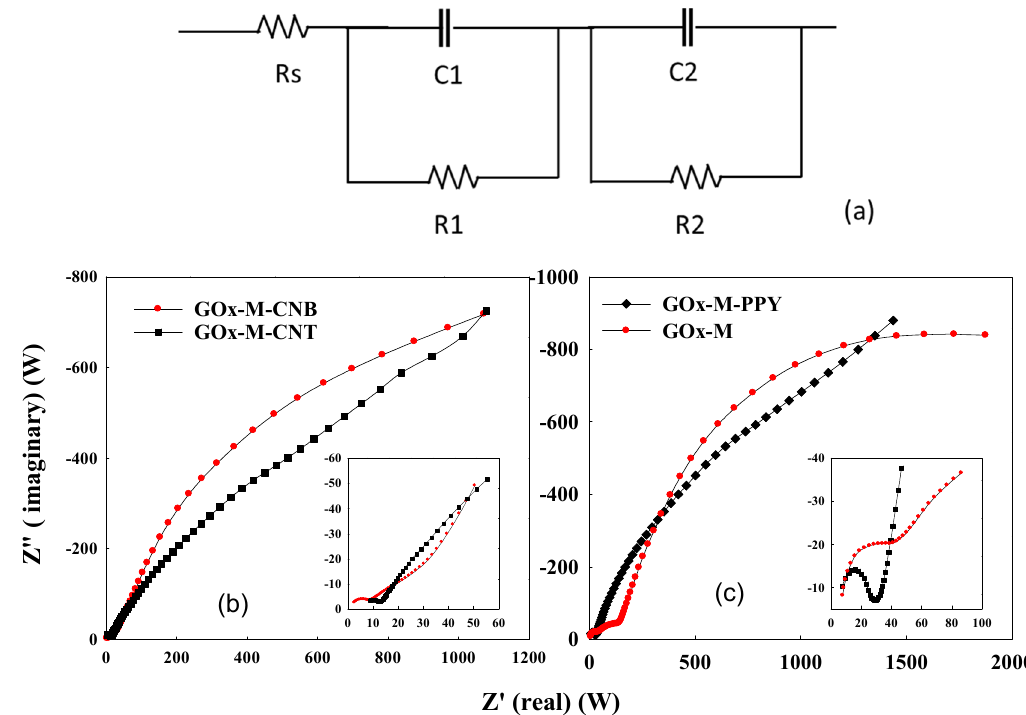
Figure 8. ( a ) Representation of Randle circuit and Nyquist plot for ( b ) GOx-M-CNB and GOx-M-CNT, and ( c ) GOx-M-PPY and GOx-M bioanode impedance of enzymatic biofuel cell (EBFC). Table 2. Impedance data for the